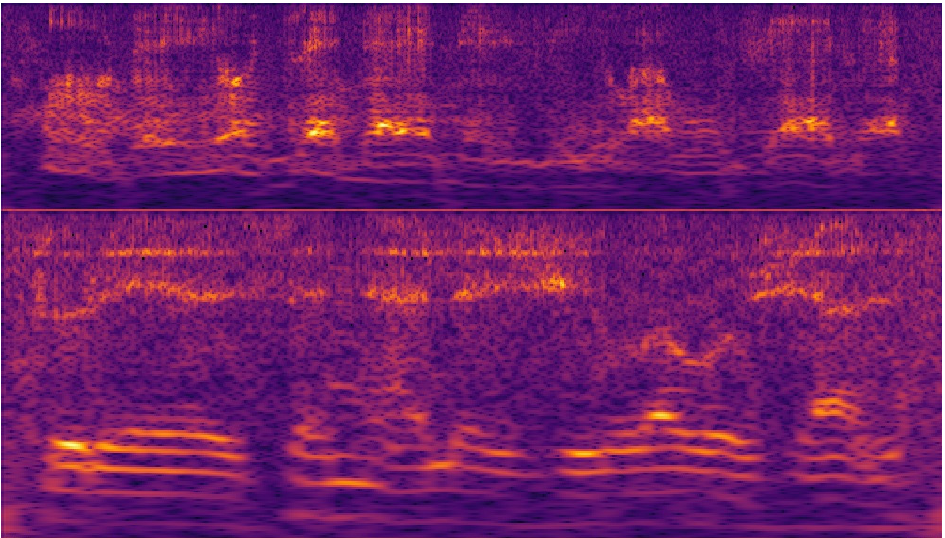
Figure 8. Cochleagrams of substitution voicing speech samples in patients after total laryngectomy with tracheoesophageal prosthesis. Multiple frequency shifts, unintended phonatory breaks, and additional noises can be observed.